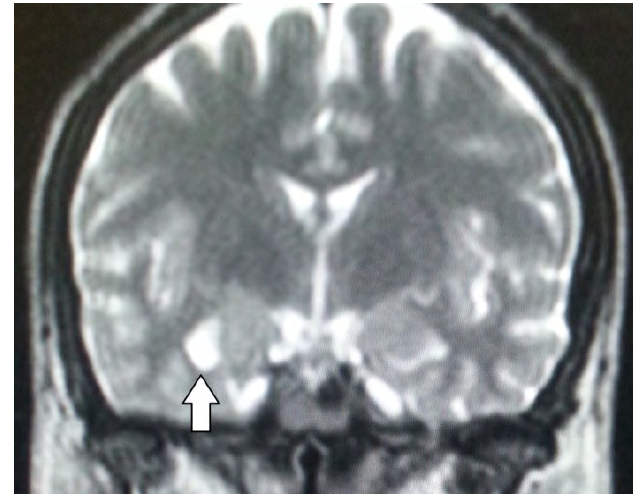
Fig 2 : T2W coronal image of brain with arrow showing asym- metric dilated CSF space in the right medial temporal lobe